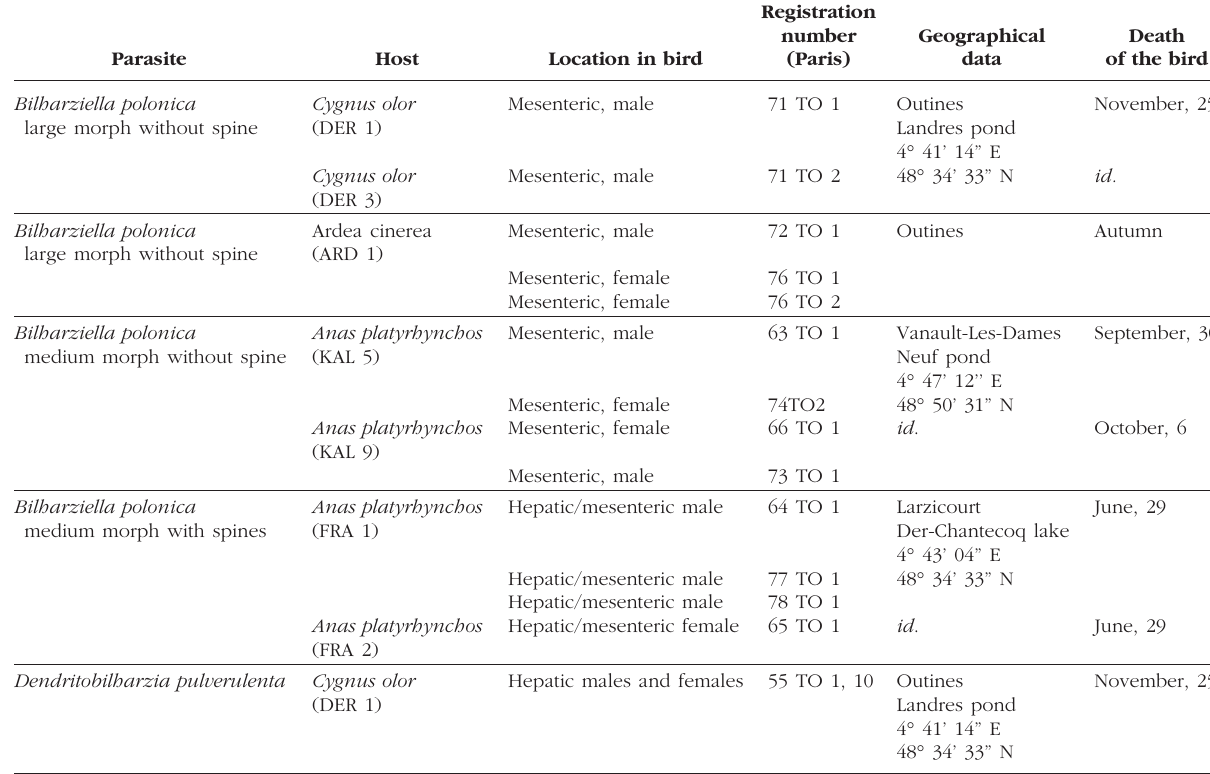
Table I. – Origin of